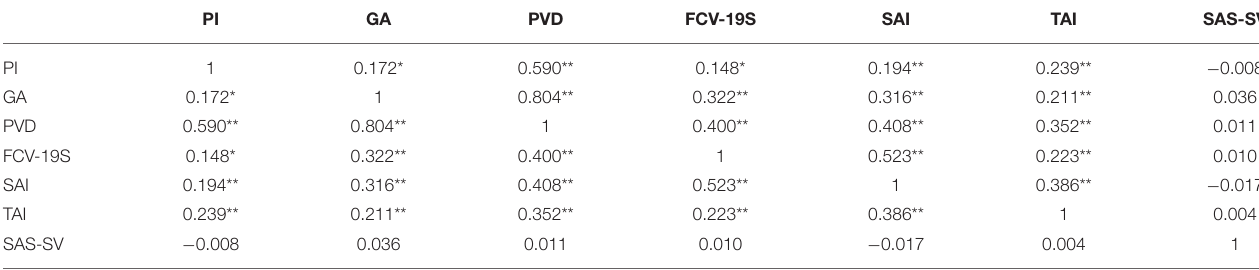
TABLE 2 | Pearson’s correlation ( r ) among FCV-19S, STAI, PVD, and SAS-SV.